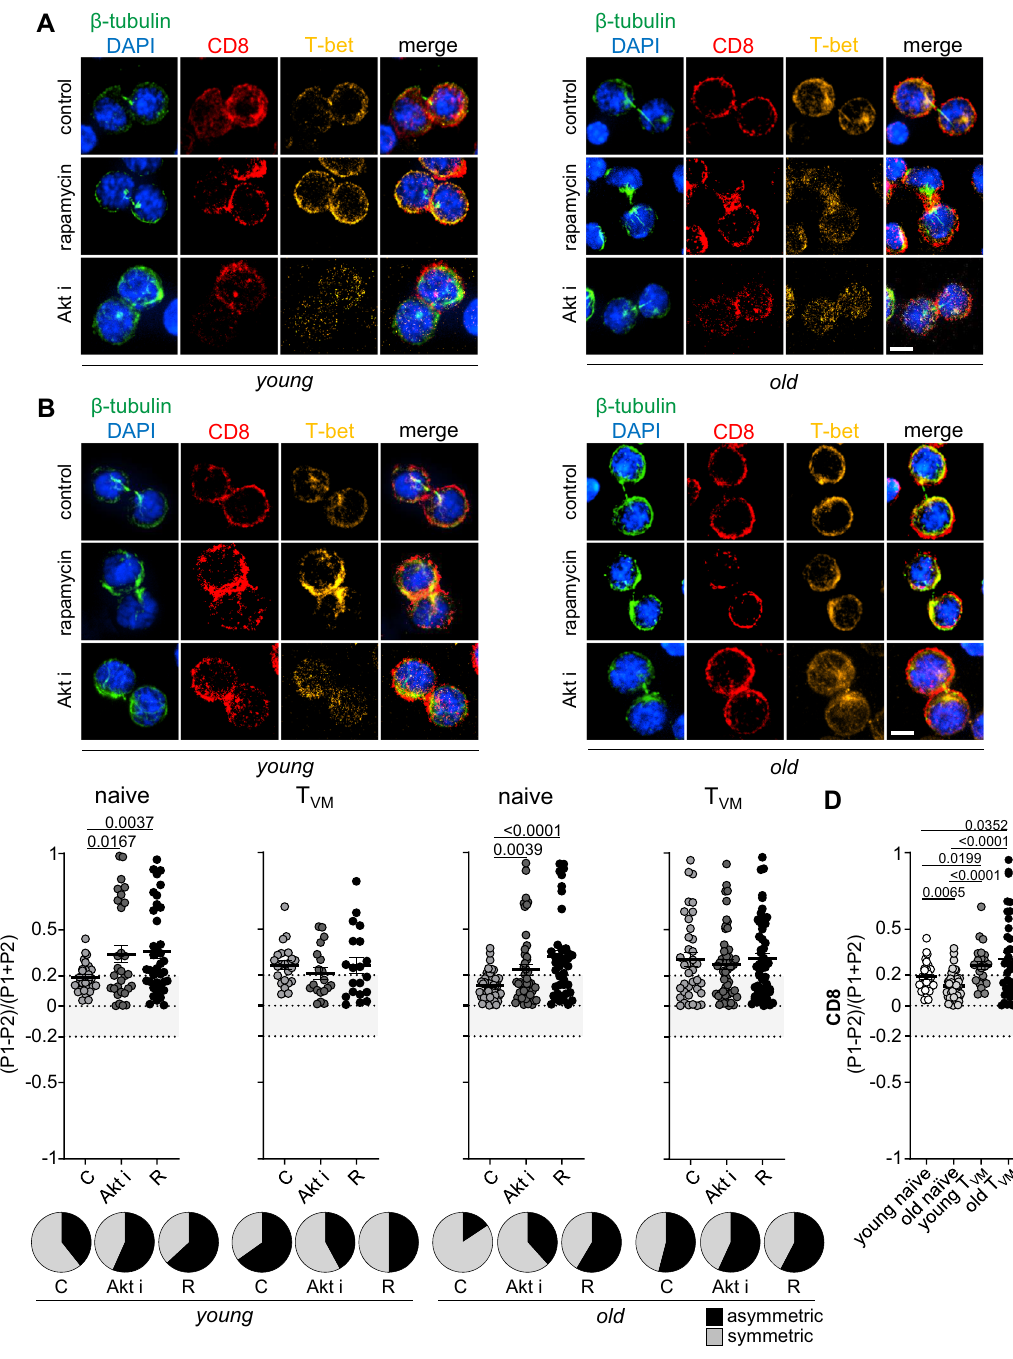
Fig. 4 T VM CD8 + T cells show intrinsically high ACD rates. A Confocal images from murine naive CD8 + T cells. B Confocal images from murine T VM CD8 + T cells. Cells were fi xed 36 – 40 h after in vitro stimulation on α -CD3, α -CD28 and human Fc-ICAM-1 coated wells. Transient mTOR inhibition was achieved by treatment with rapamycin (20 nM) or Akt-kinase inhibitor (5 µ M). Cells were exposed to drug treatment from 12 h post activation until fi xation for confocal microscopy analysis. Scale bar = 5 µ m. C CD8 asymmetry rates in naive and T VM CD8 + T cells isolated from young or old mice (young naive C, n = 28; young naive Akt i, n = 30; young naive R, n = 38; young T VM C, n = 23; young T VM Akt i, n = 19; young T VM R, n = 20; old naive C, n = 51; old naive Akt i, n = 47; old naive R, n = 42; old T VM C, n = 37; old T VM Akt i, n = 51; old T VM R, n = 52). Frequencies of asymmetrically dividing cells are depicted in pie charts on the right side of each graph. D Comparison of CD8 polarization amongst young naive, old naive, young T VM and old T VM CD8 + T cells (young naive, n = 28; old naive, n = 51; young T VM , n = 23; old T VM , n = 37). Data are shown as mean ± SEM. Pooled data from fi ve independent experiments (aged mice: 71, 95, 97, 102 or 108 weeks old). For each experiment sorted cells from at least two animals were pooled. Statistical analysis was performed using the unpaired two-tailed Student ’ s t test. Exact P values are depicted in the fi